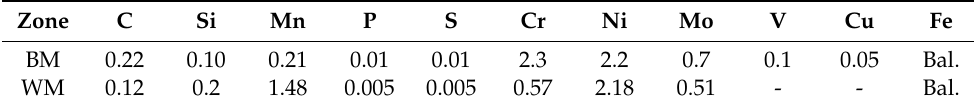
Table 1. The chemical compositions of base metals and weld metals (in wt.%).